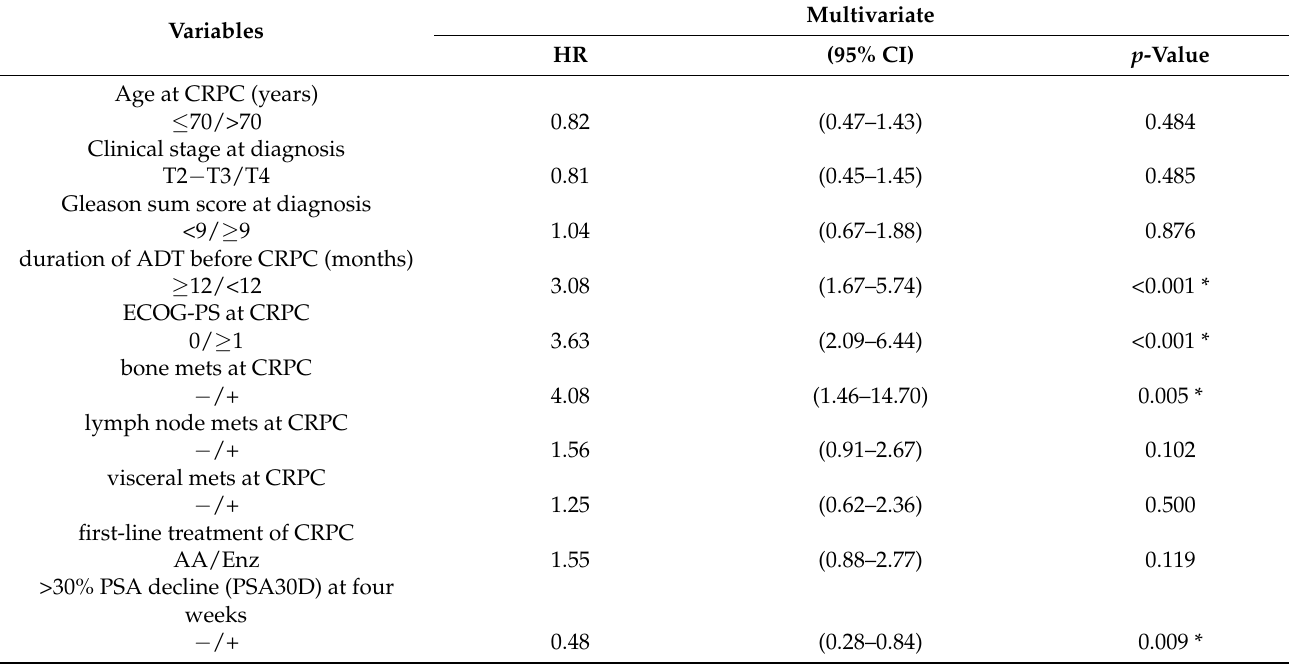
Table 2. Multivariate analysis for OS in 254 mCRPC patients treated with AA or Enz at the first-line treatment. Variables